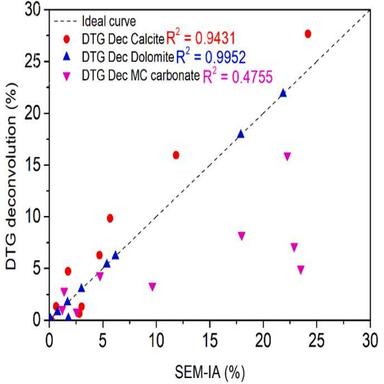
Comparation of DTG and SEM-IA results for dolomite, calcite and microcrystalline carbonate.